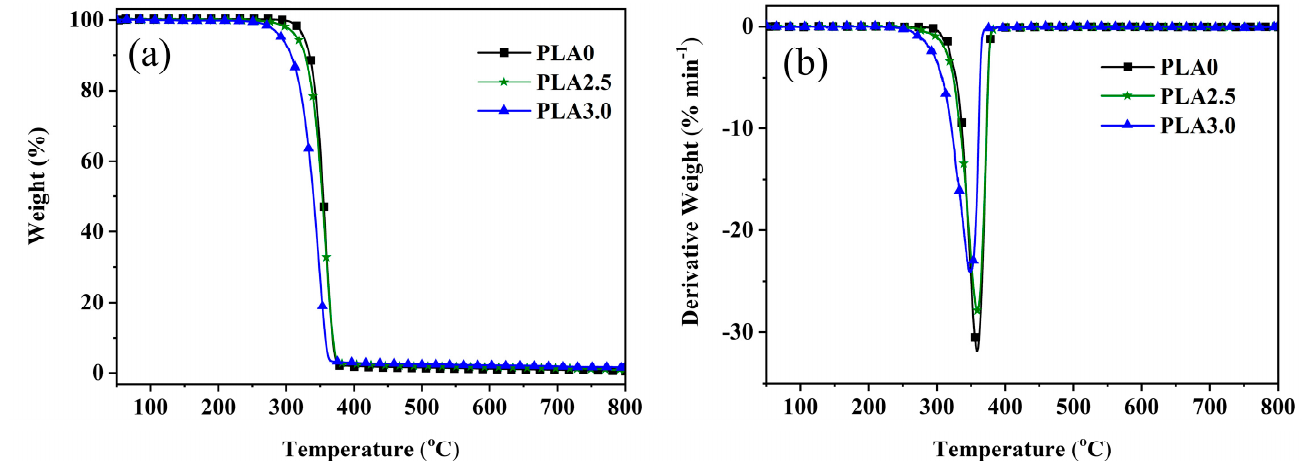
Table 3. Thermal degradation data of PLA/MKF/NTPA biocomposites.